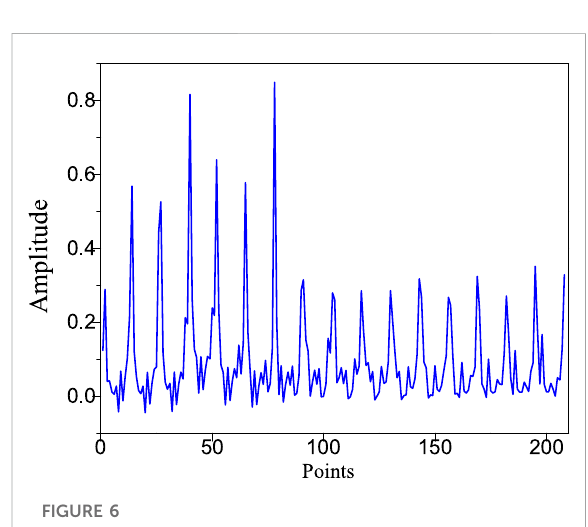
FIGURE 6 Boundary voltage data collected for Experiment